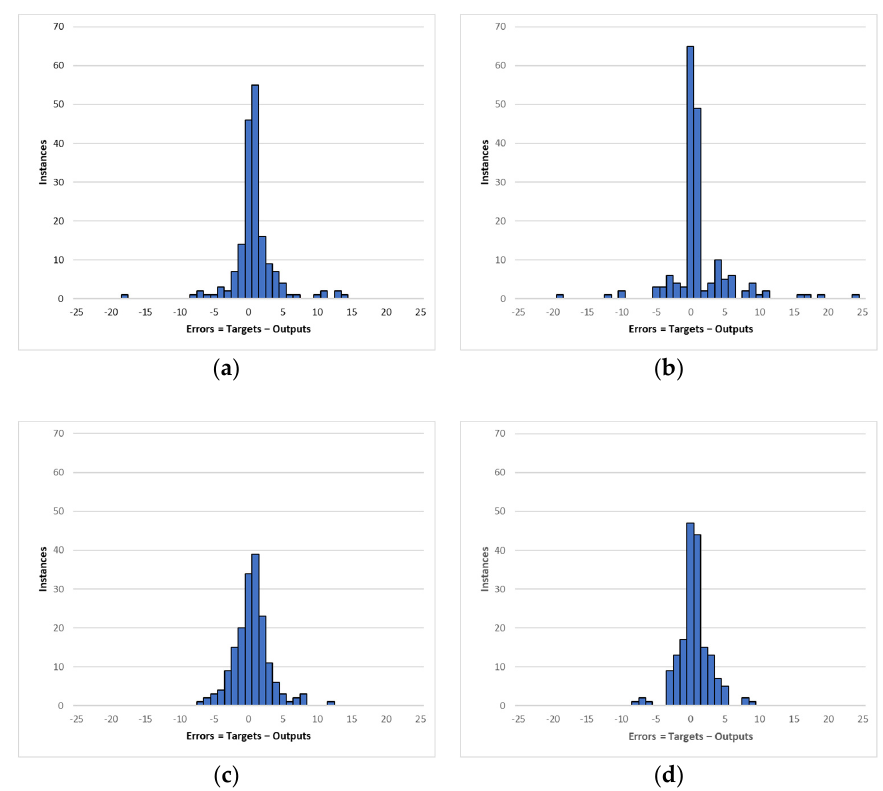
Figure 3. Distribution of errors for the training methods tested. ( a ): LM-15; ( b ): LM-20; ( c ) BR-15; ( d ): BR-20.